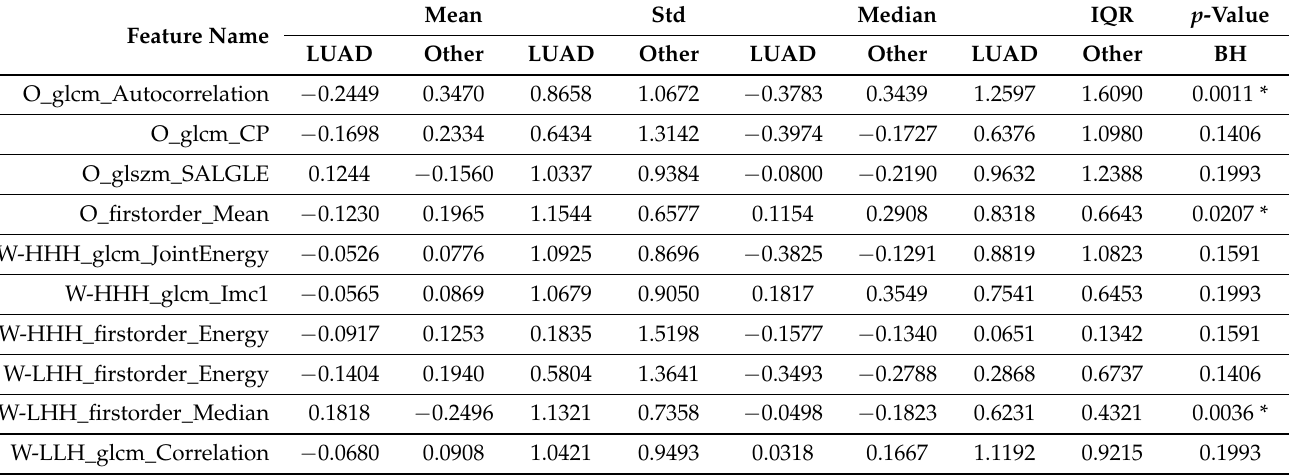
Table 2. Statistics for features distribution between adenocarcinoma and other cases. Std is the standard deviation, IQR is the interquartile range. Mann–Whitney U tests was used to calculate the p -values. The multiple comparisons problem was handled with Benjamini–Hochberg (BH) correction. * indicates statistically significant features ( p -value <